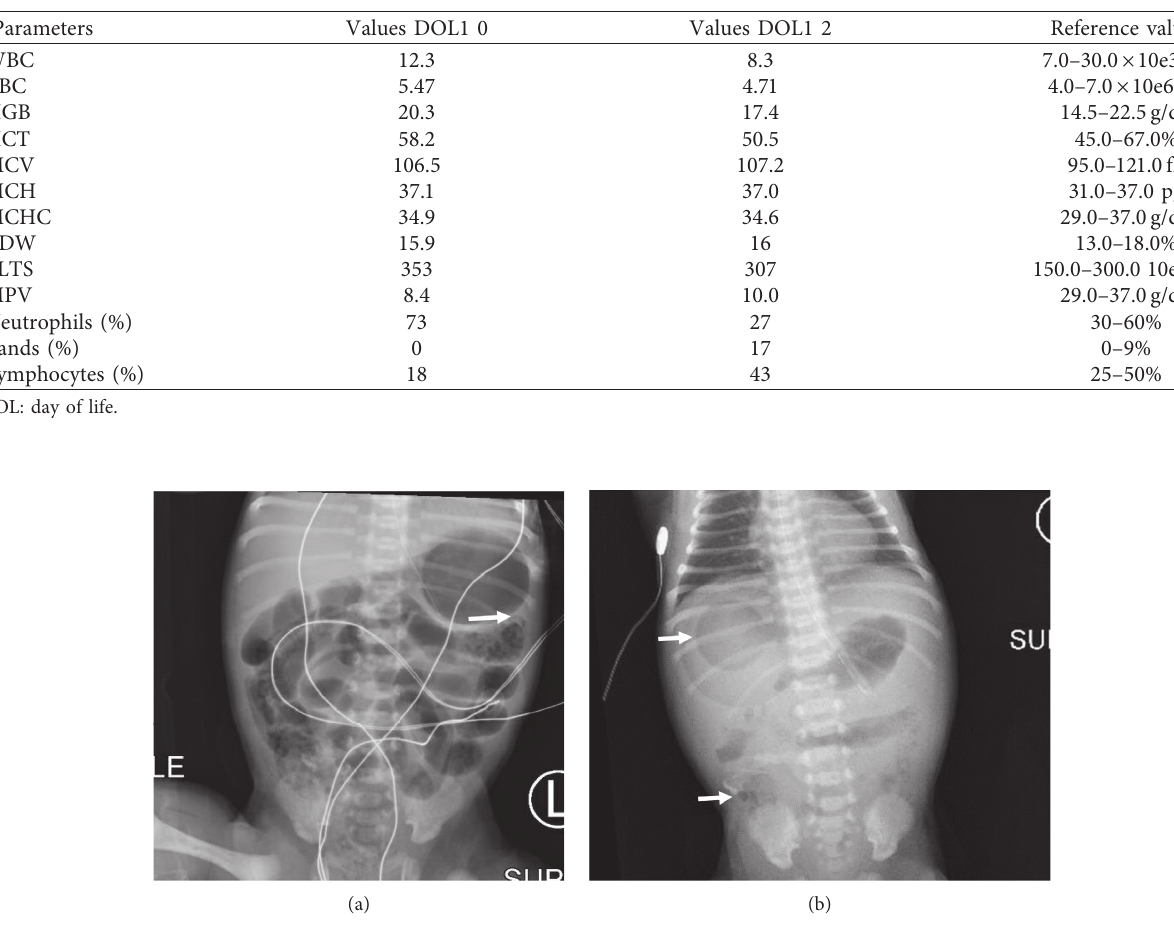
Table 1: Infant’s complete blood cell count (CBC) values at two time points after